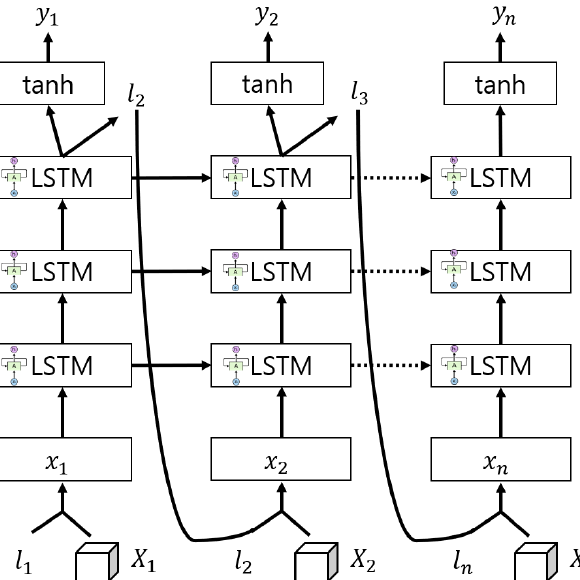
Figure 3. Our recurrent model. At each time-step t , our recurrent network takes a feature slice x t , generated as in Figure 4, as the input. It then propagates x t through three layers of LSTMs and predicts the next location probabilities I t + 1 and the class label y t